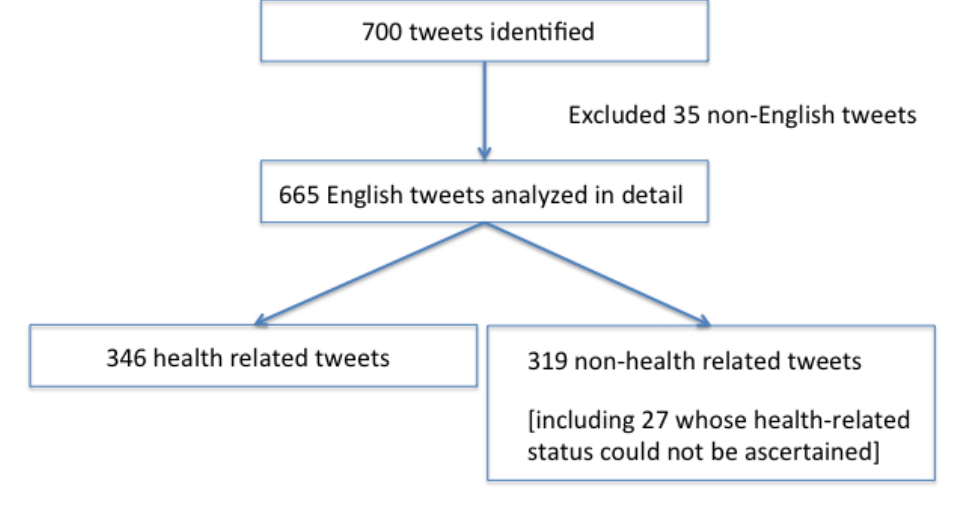
Figure 2. Inclusion and exclusion of